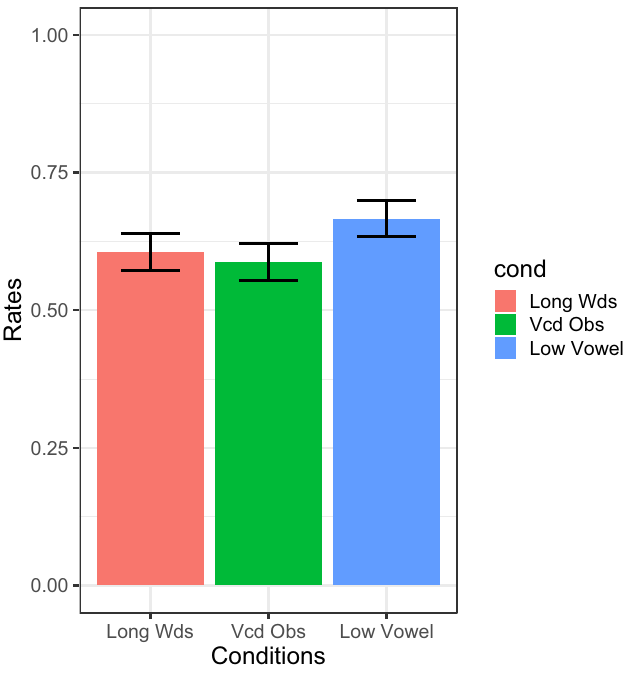
Figure 3: Rates at which the nonce words in the experimental groups were chosen as powerful spells by those unfamiliar with the Harry Potter series ( n = 36 )